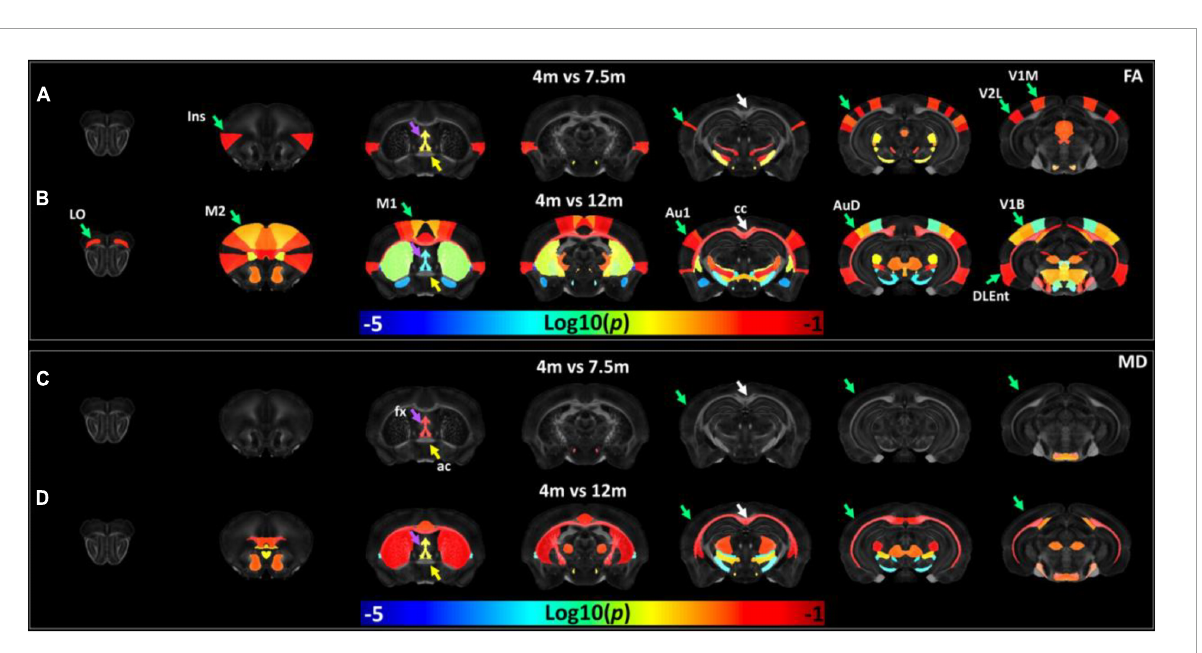
FIGURE7 The age-dependent whole-brain microstructure changes in 5xFAD mice. The fractional anisotropy (FA) statistic maps ( A,B ) exhibited higher sensitivity to the age effect compared to mean diffusivity (MD) ( C,D ). Ins, insular cortex; V1M, primary visual cortex monocular area; V2L, secondary visual cortex lateral area; fx, fornix; M1, primary motor cortex; M2, secondary motor cortex; LO, lateral orbital cortex; Au1, primary auditory cortex; AuD, secondary auditory cortex dorsal part; V1B, primary visual cortex binocular area; DIEnt, dorsal intermediate entorhinal cortex; cc, corpus callosum; Cpu,